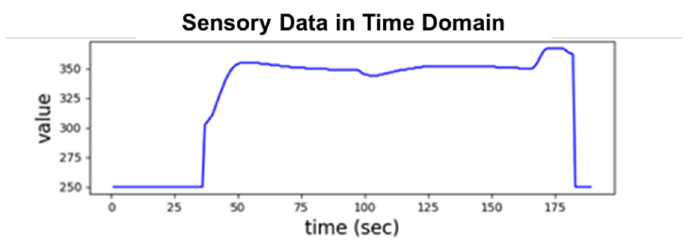
Figure 1. A cycle of sample sequence from an SVID collected from an HDP-CVD tool.